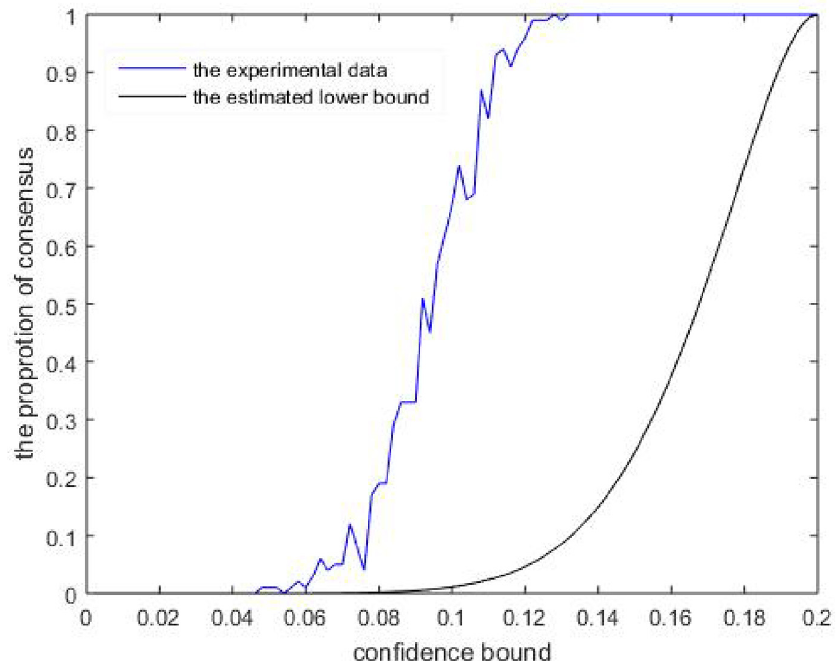
Fig 1. The probability of opinion consensus as ε 0 increases. The estimated curve is calculated by the proportion of Δ ( T ) < ε 0 for 100 times of simulations.